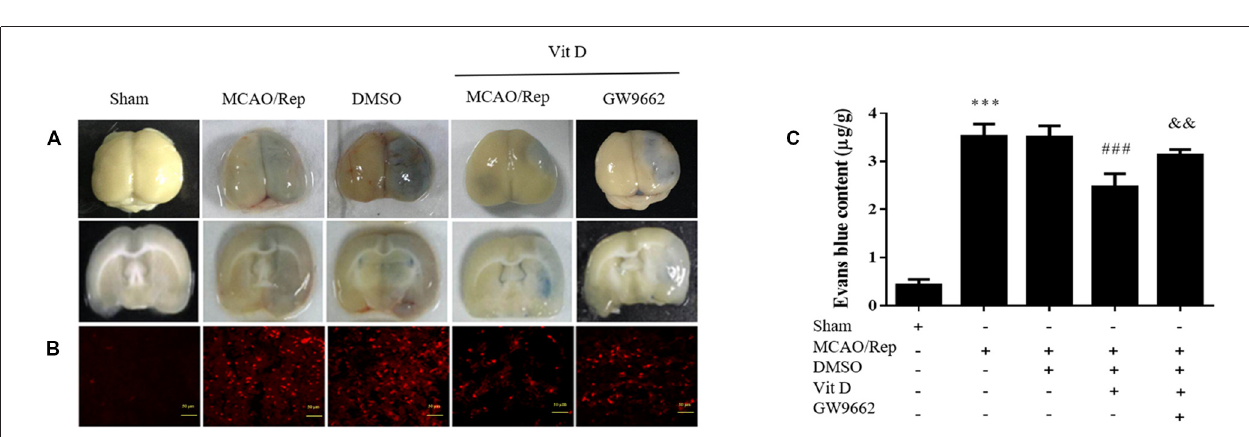
FIGURE 3 | 1, 25-D 3 (Vit D) protected against neuronal injury induced by cerebral ischemic reperfusion 24 h after MCAO/R. (A–E) Representative pictures of hematoxylin-eosin (HE) stained cerebral cortex. (F) Number of positively stained cells in the cerebral cortex was analyzed using the ImageJ software (400 × magnification). Data are represented as Mean ± SEM, n = 6, ∗∗∗ P < 0.001 vs. sham group, ### P < 0.001 vs. DMSO group, && P < 0.01 vs. 1, 25-D 3 group. MCAO/R, middle cerebral artery occlusion/reperfusion; DMSO, Dimethyl sulfoxide; 1, 25-D 3 , 1, 25-dihydroxyvitamin D 3 ; GW9662, inhibitor of PPAR- γ .